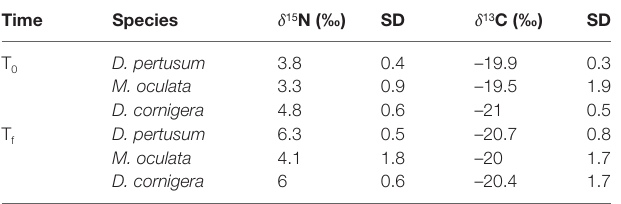
TABLE 2 | Mean δ 15 N and δ 13 C of the corals at the beginning (T 0 ) and at the end (T f ) of the experiment.